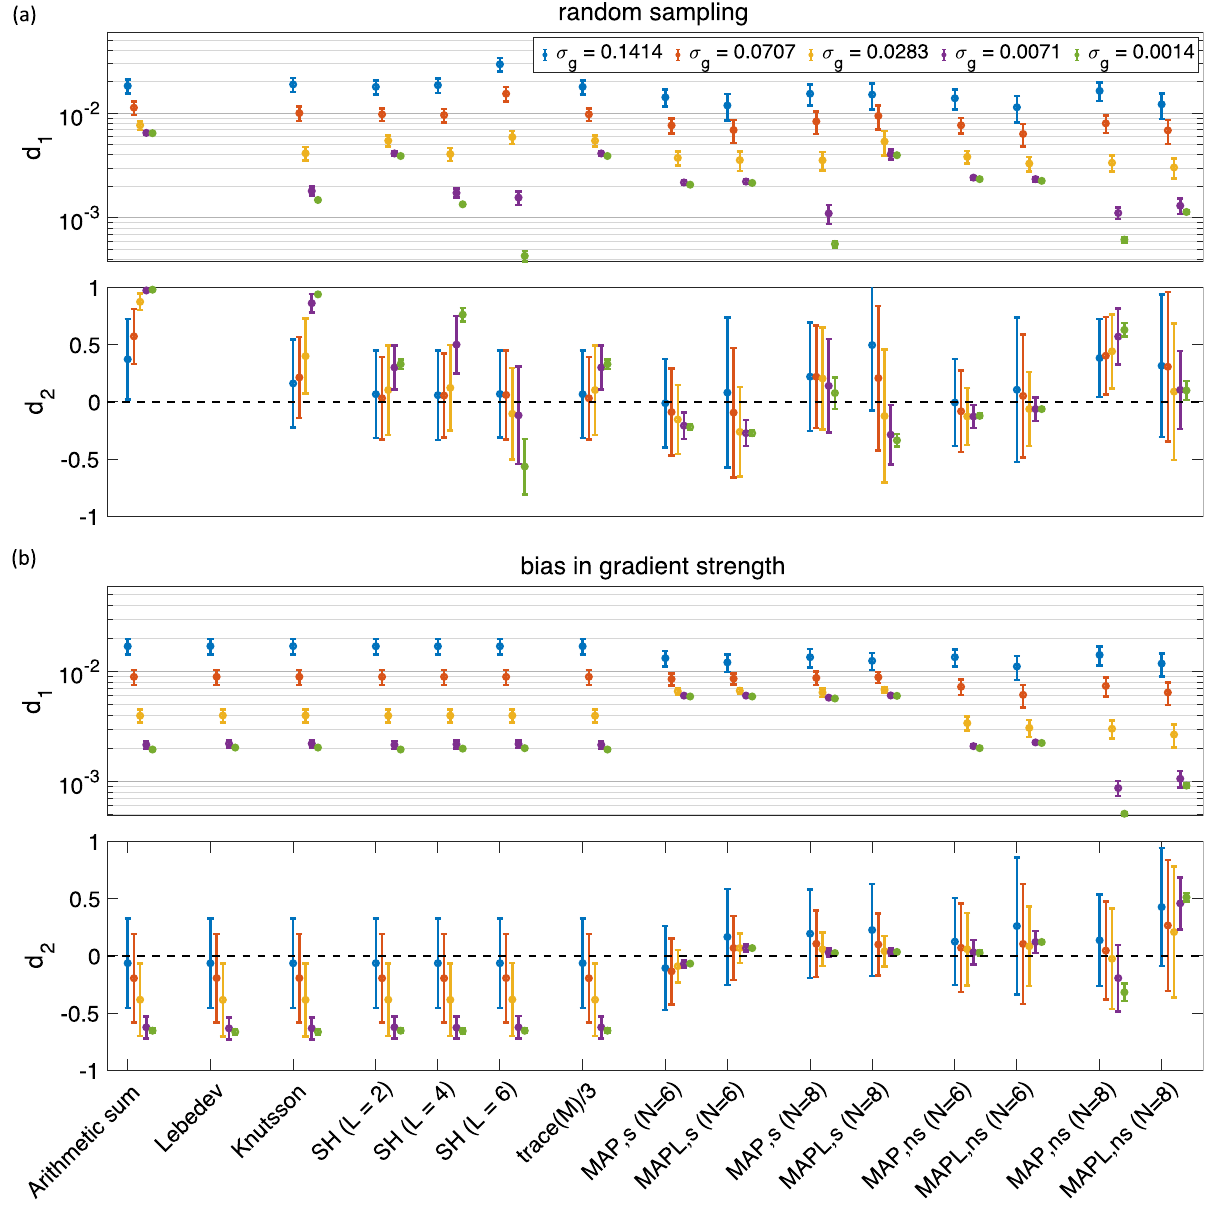
Figure 5. The mean and std of the d 1 and d 2 measures for 344 (43 random sampling scheme, and ( b ) bias in gradient strength (the y-axis in d 1 is scaled logarithmically). The ‘s’ and ‘ns’ correspond to the shelled and non-shelled point sets, respectively. Different colors (blue, red, yellow, purple, green) show the results in different noise levels ( σ g